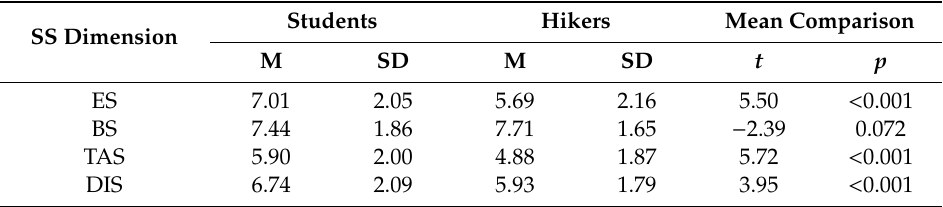
Table 2. Description and mean comparison of SS (sensation seeking). Students Hikers Mean SS Dimension